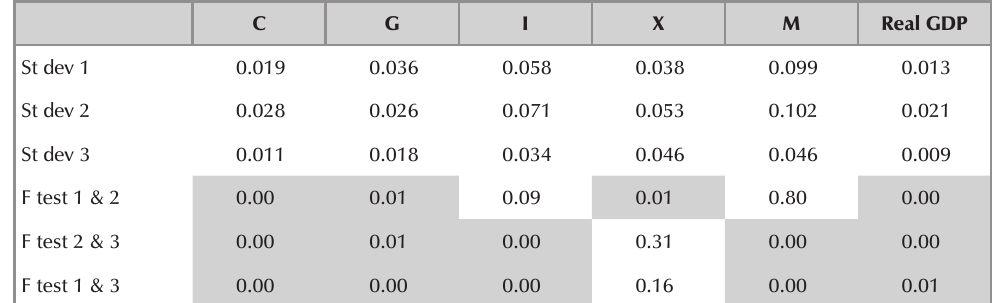
Standard deviations of GDP and the components of aggregate expenditure